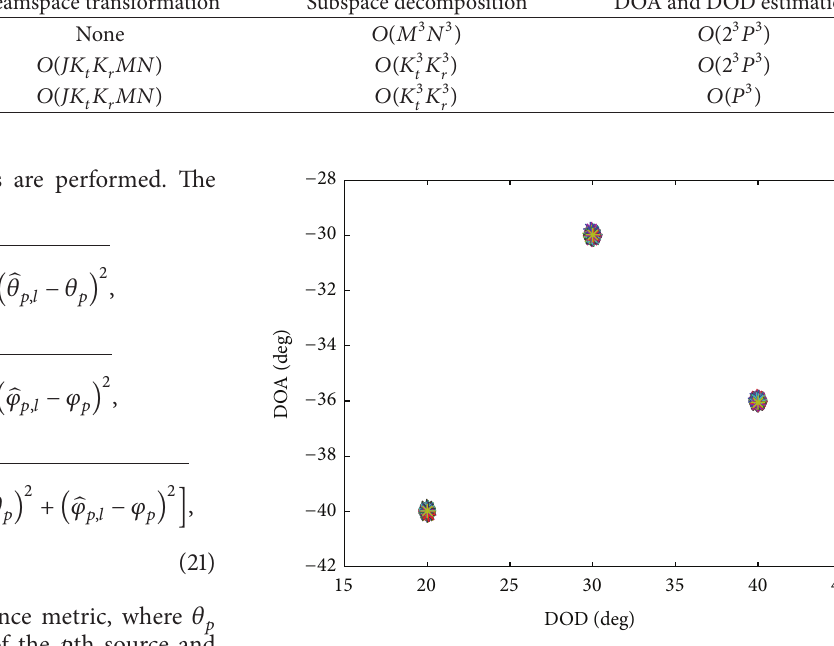
Figure 2: Angle estimation results with SNR = 15